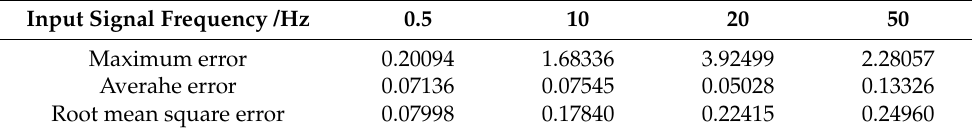
Table 4. The calculated output displacement error of different control